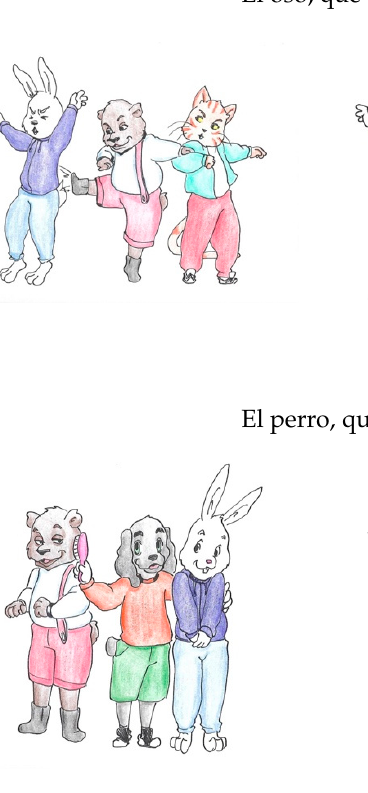
Figure A20. ORC stimulus 5.